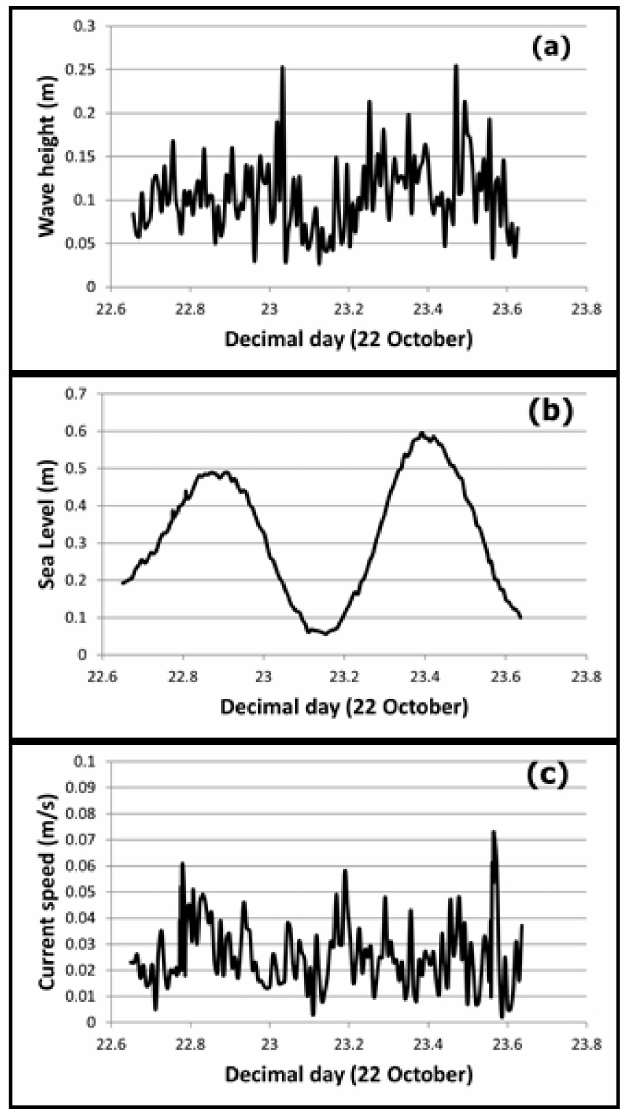
Figure 9. Measurements at the study site: ( a ) wave height with a trend line; ( b ) sea level; and ( c ) current